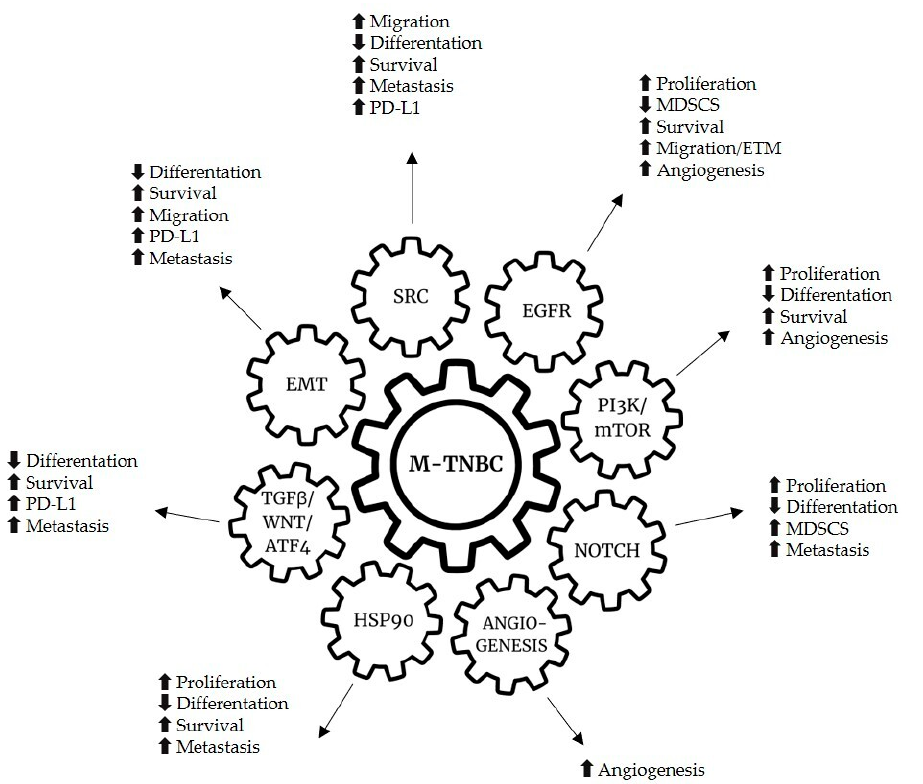
Figure 2. Genetic alterations and hallmarks of mesenchymal breast cancer triple negative subtype.